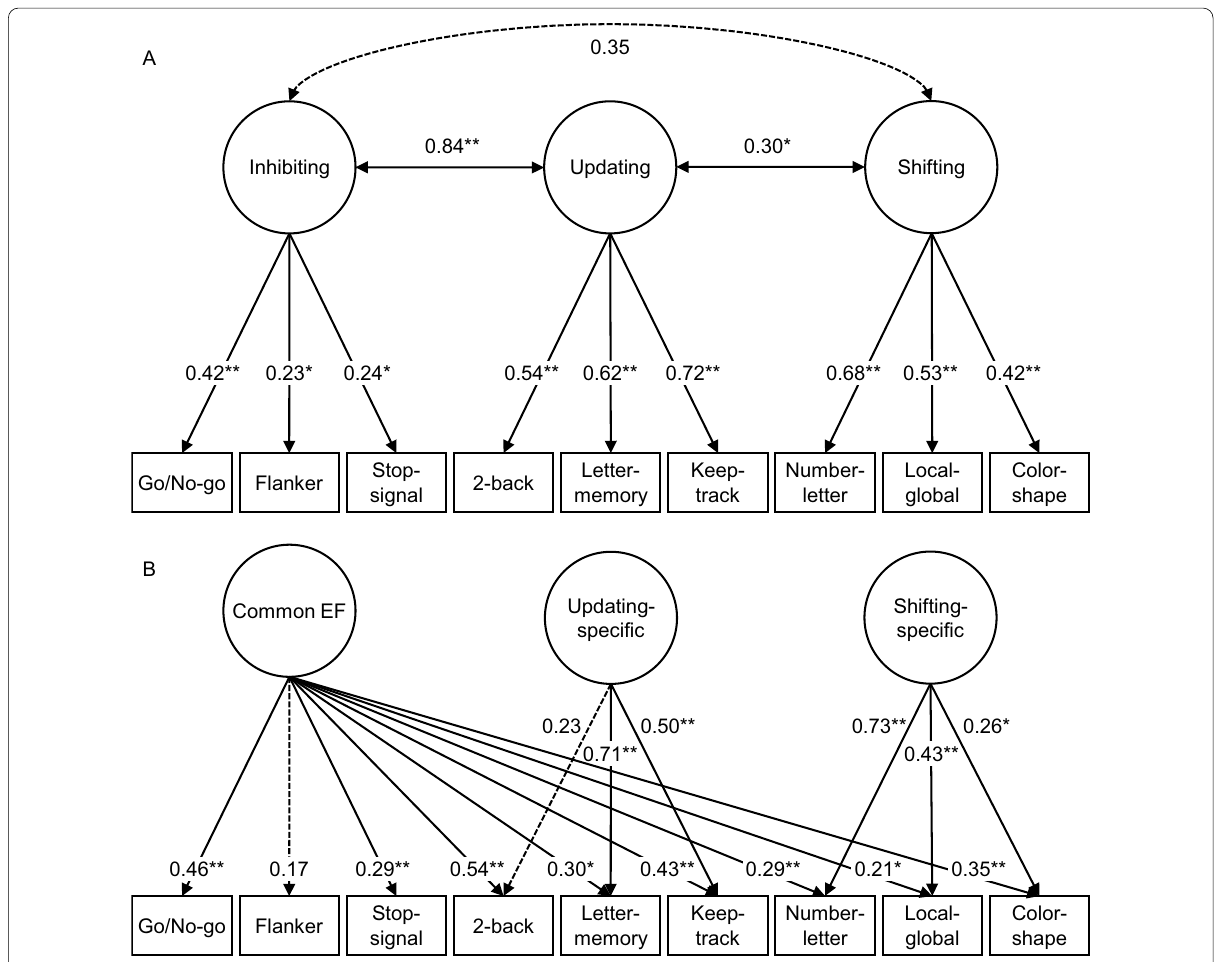
Fig. 2 Illustration of path loadings for the correlated factors model ( A ) and the bifactor model ( B ) parametrizations ( N functioning. Solid lines represent significant loadings and dashed lines represent non‑significant loadings. * p < .05, ** p <